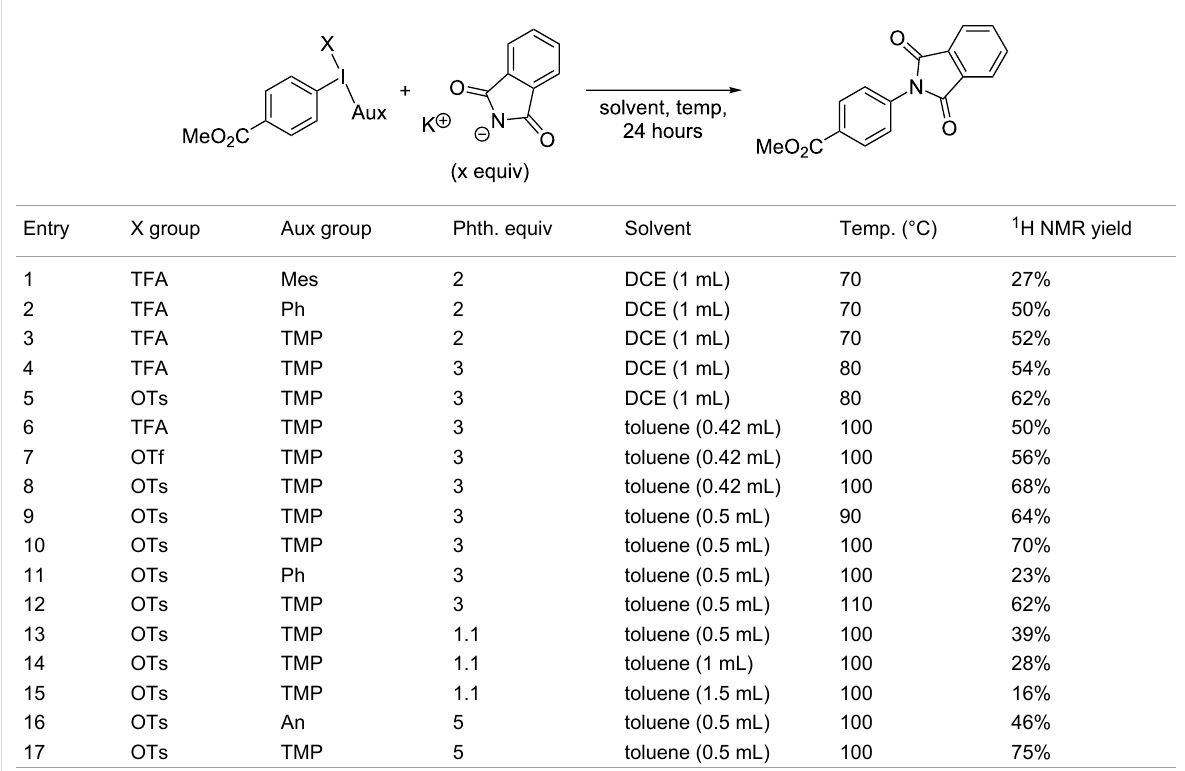
iaries under several different reaction conditions (Table 1, entries 1–3; 11 and 12; 16 and 17). While the counter anion